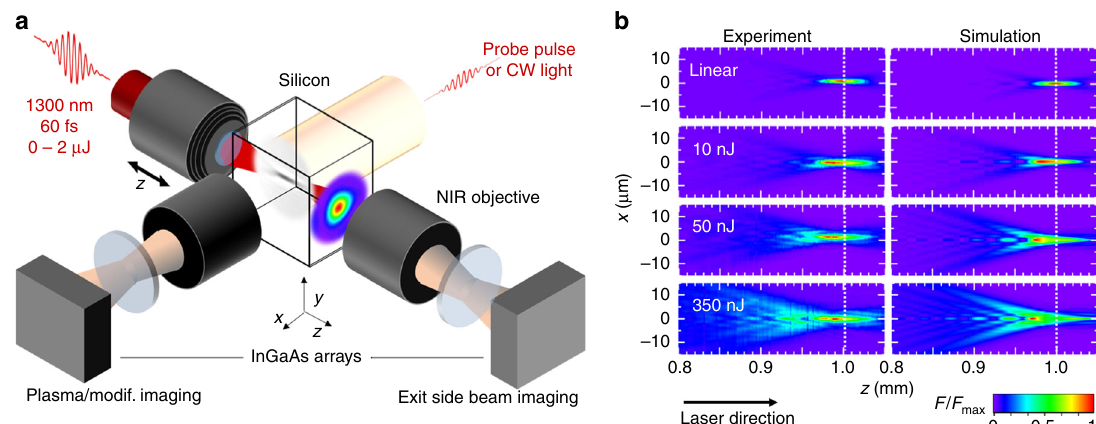
Fig. 1 Accessing ultrafast laser energy and plasma density inside silicon. a Simpli fi ed schematic of the measurement methods: Two customized infrared microscopes, each composed of an objective, a tube lens and an InGaAs camera, are positioned laterally and along the optical axis. Ultrashort probe pulses illuminate the interaction region for lateral imaging of transient microplasmas and permanent modi fi cations. Beam pro fi ling at the exit surface of the sample is performed to retrieve, by a z -scanning procedure, the 3D distributions of the delivered laser fl uence inside silicon. b Cross-sections of fl uence distributions for ultrashort pulses focused in silicon with a numerical aperture of 0.45: The beam focus is positioned at a depth of 1 mm inside silicon as shown by the dotted white lines . Measurements and simulations are compared for increasing pulse energies up to 350 nJ as labeled for each row (the label “ linear ” stands for a sub-nanojoule energy ensuring the absence of nonlinear effects). All distributions are normalized to their maximum fl uence F